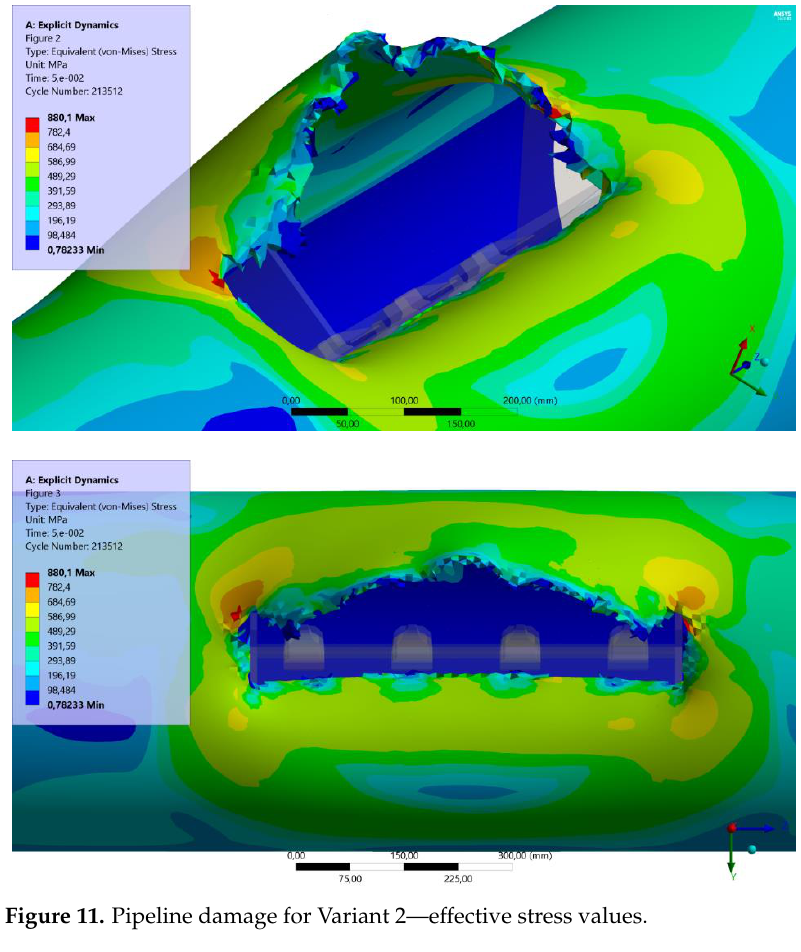
Figure 11. Pipeline damage for Variant 2—effective stress values.